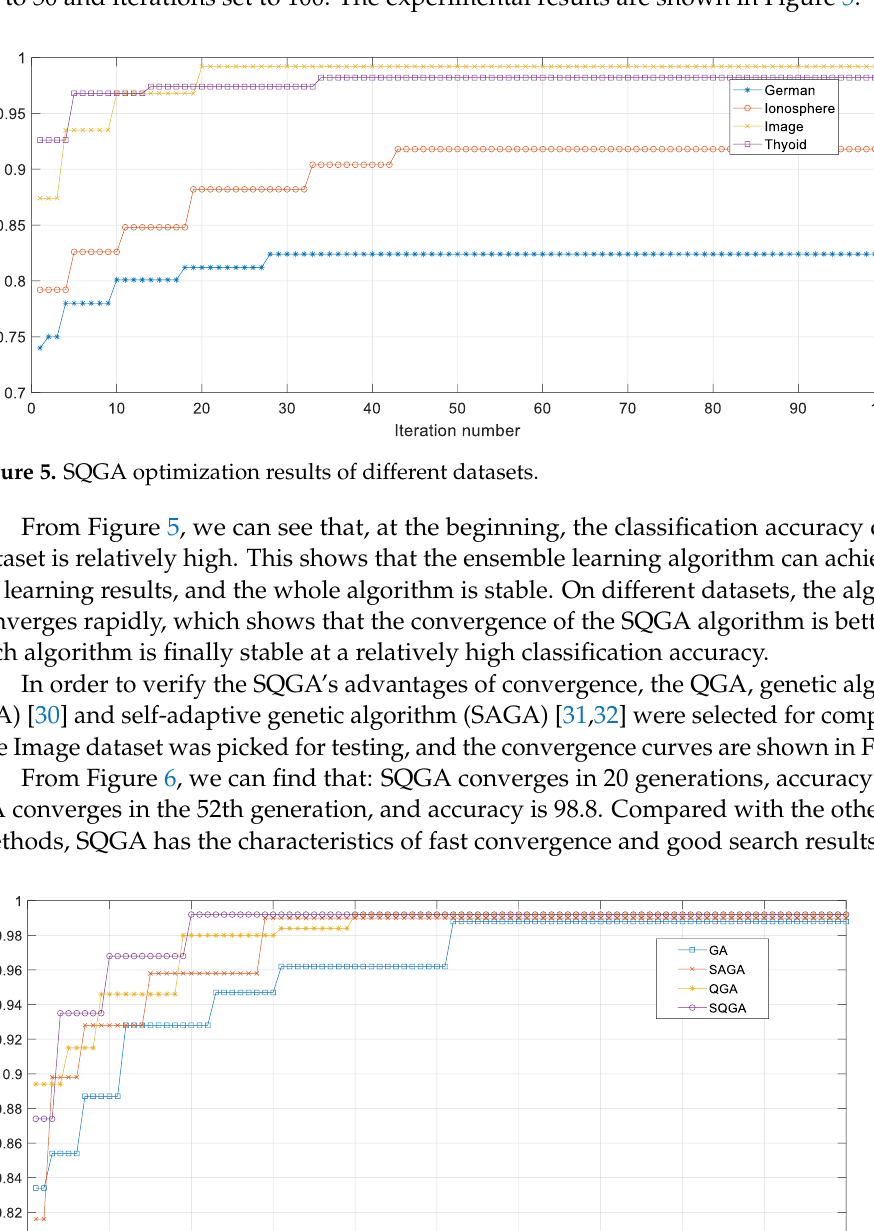
Table 1. Experimental accuracy on general datasets.